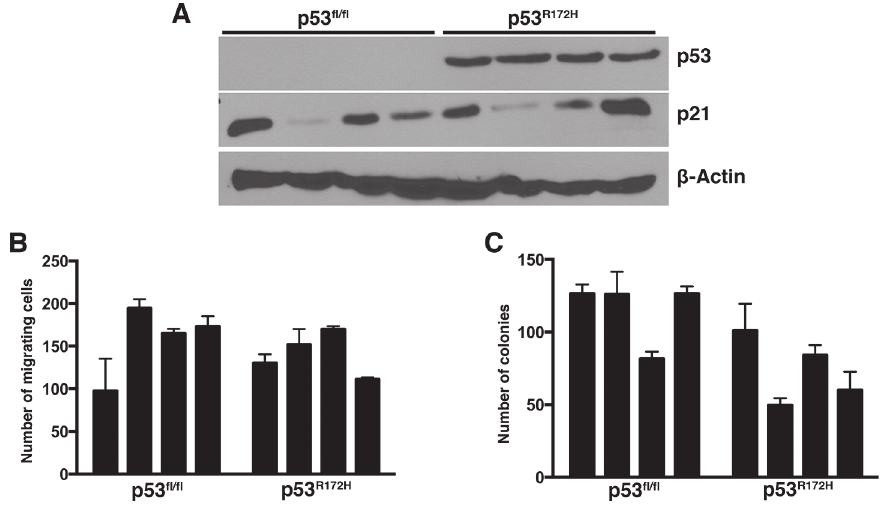
Fig 2. Cell lines derived from p53 R172H -expressing HCCs do not display enhanced properties when compared to p53-null HCCs. A) Immunoblots demonstrating expression of p53 and p21 in selected mouse tumor-derived cell lines. B) Transwell migration assay of HCC cell lines derived from p53 fl/fl and p53 R172H tumors. C) Soft agar colony formation assay of HCC cell lines derived from p53 fl/fl and p53 R172H tumors.